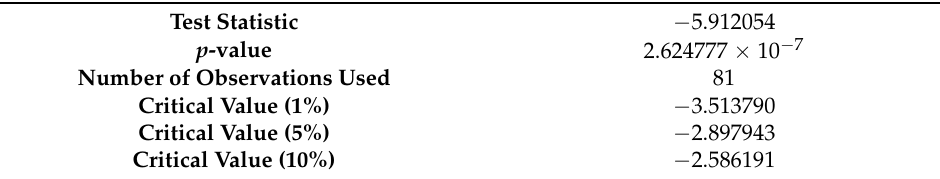
Table 1. Unit root test results of second-order difference data.